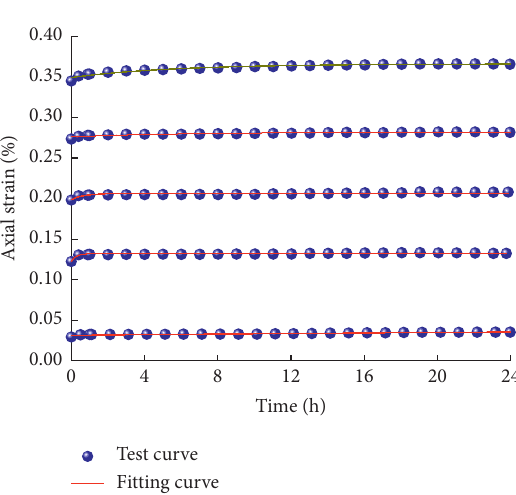
Figure 8: Comparison of test curve and fitting curve of the Cvsic model.